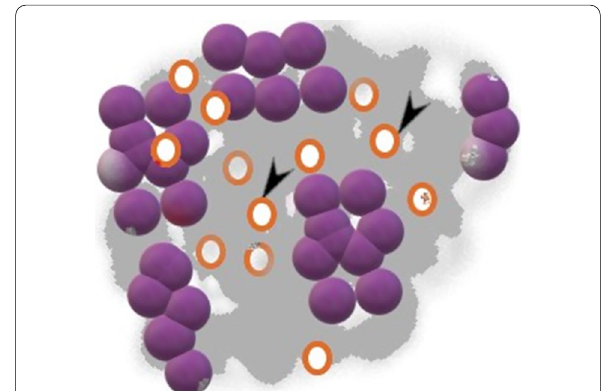
Fig. 1 An artwork depicting the role of membrane vesicles (Orange spheres, indicated by arrows) interlinking the microcolonies of biofilm producing Gram-positive typical Staphylococci